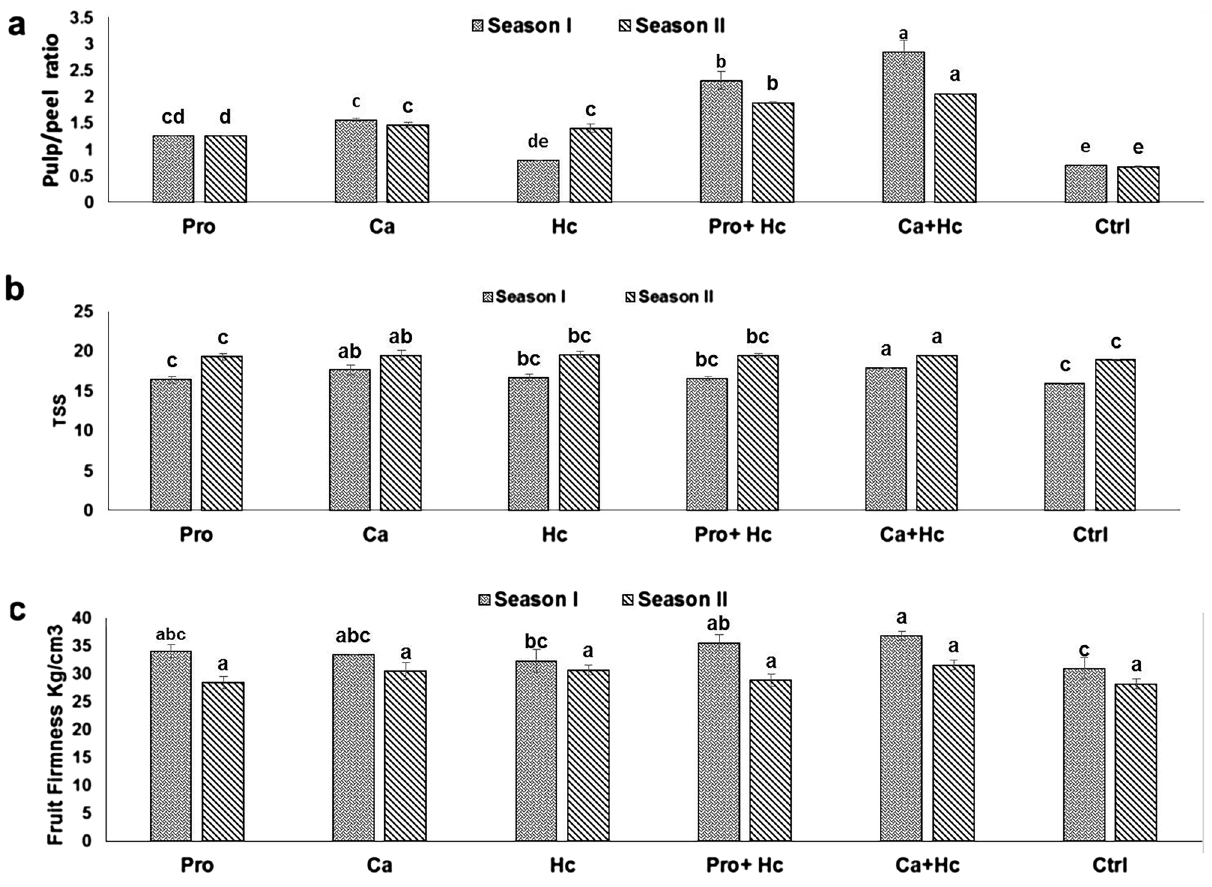
5 mM proline alone as foliar application; Ca: 1.5% Calcium as foliar application alone; Hc: 15 g humic acid as soil application alone; Pro + Hc: 5 mM porline and 15 g humic acid; Ca + Hc: 1.5% calcium and 15 g humic; Ctrl: control (non